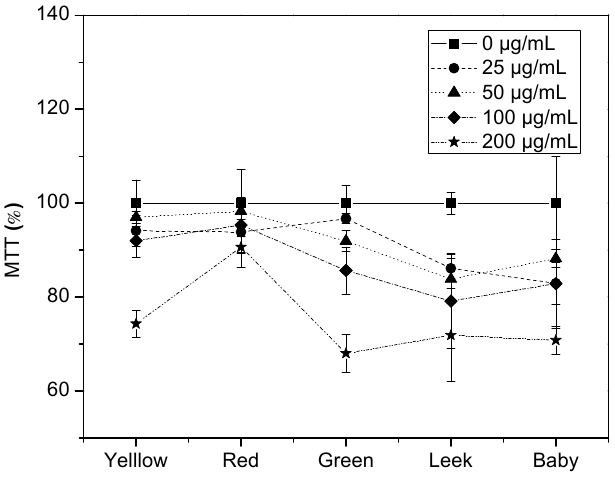
Figure 2. Cell viability of onion varieties.